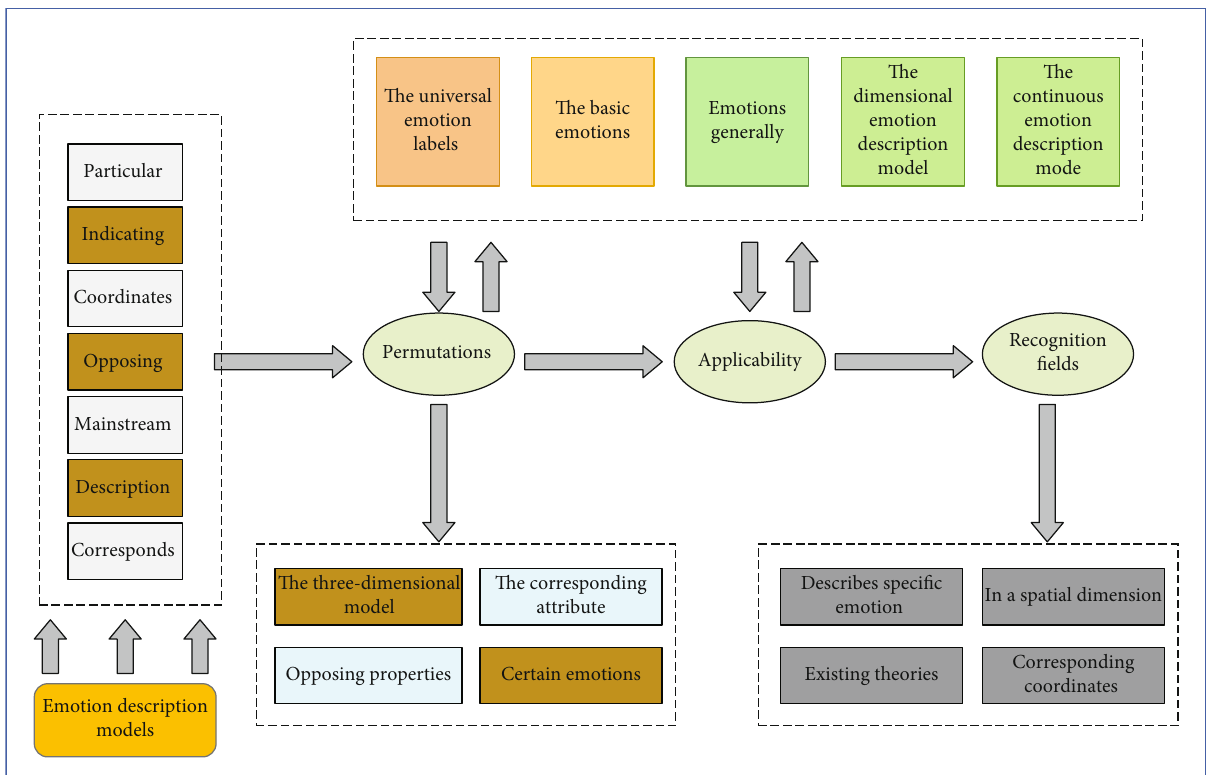
Figure 2: PAD a ff ective description